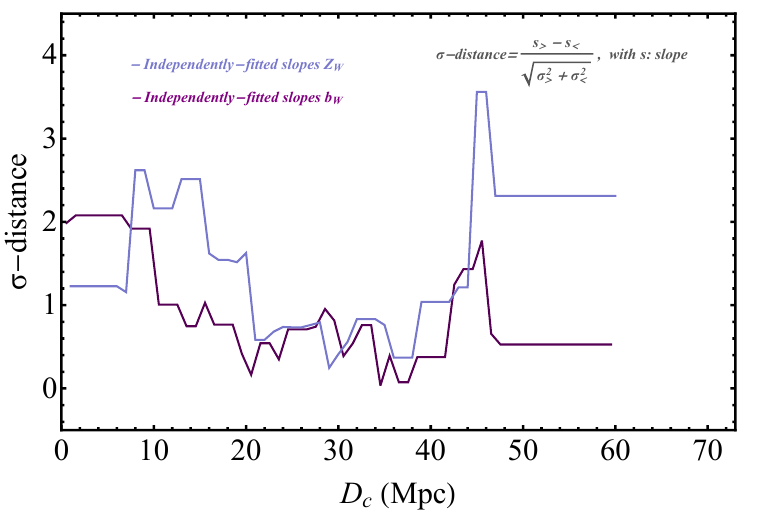
Figure 5. The σ distance between the best-fit high-distance bin ( D > D c ) and low-distance bin slopes ) and s < ( b < ) ) defined in Equation (31) for Z ( s > ( b > , Z > , Z < W W W W